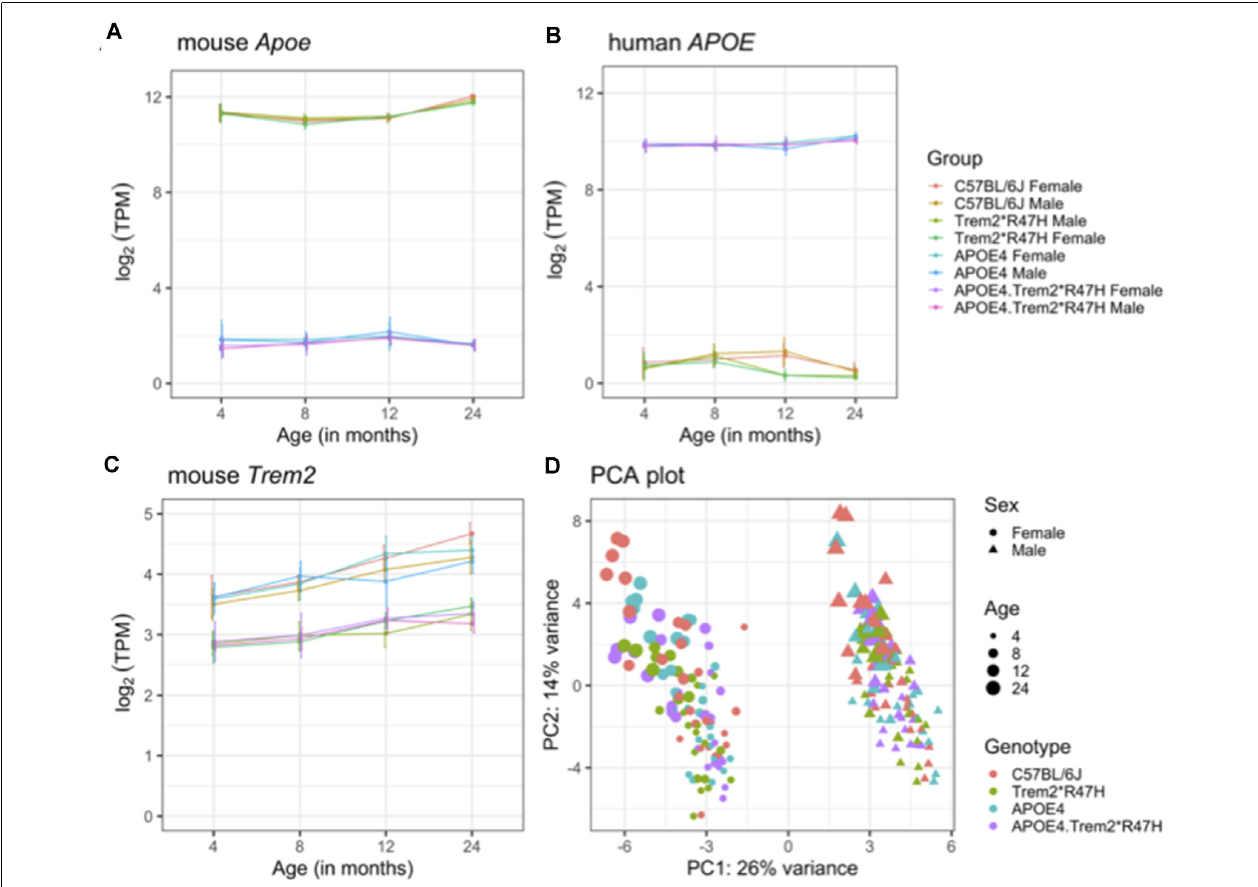
FIGURE 6 | Overview of brain transcriptome. Expression levels of mouse Apoe (A) , human APOE (B) , and mouse Trem2 (C) genes in the B6. APOE4 , B6. Trem2*R47H , B6. APOE4.Trem2*R47H and C57BL/6J mice at 4, 8, 12, and 24 months in both sexes. Principal component analysis (PCA) of RNA-Seq transcriptomics data from all 234 samples (D) . The percent of variation explained by each principal component is displayed on the corresponding axis. Female and male samples are represented as circles and triangles, respectively. Genotypes are shown by different colors and the increasing size of points correspond to the increasing age of mice (4, 8, 12, and 24 months respectively). All alleles expressed were homozygous.